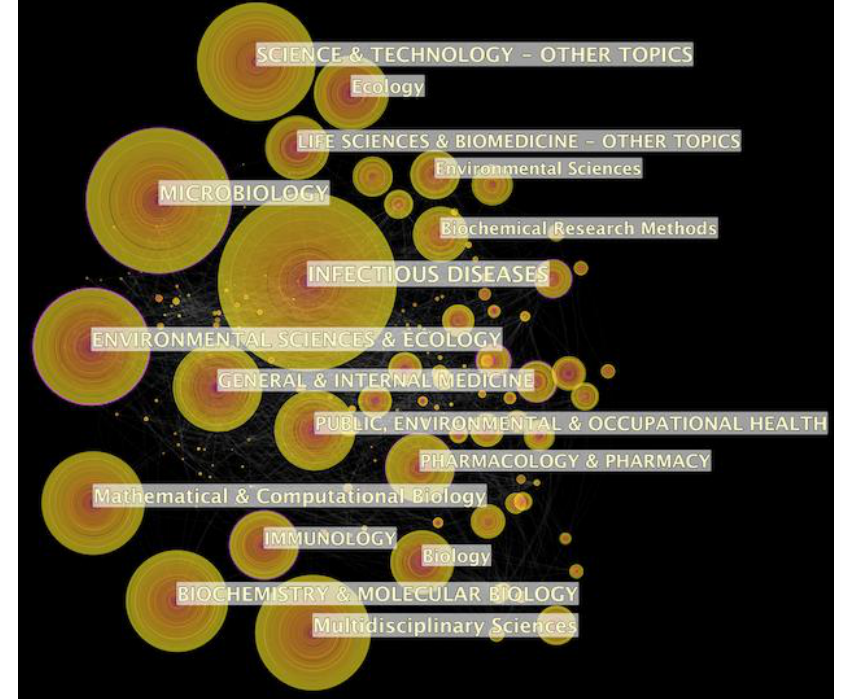
Figure 3. Co-occurrence network of categories in the field of prediction of infectious diseases.